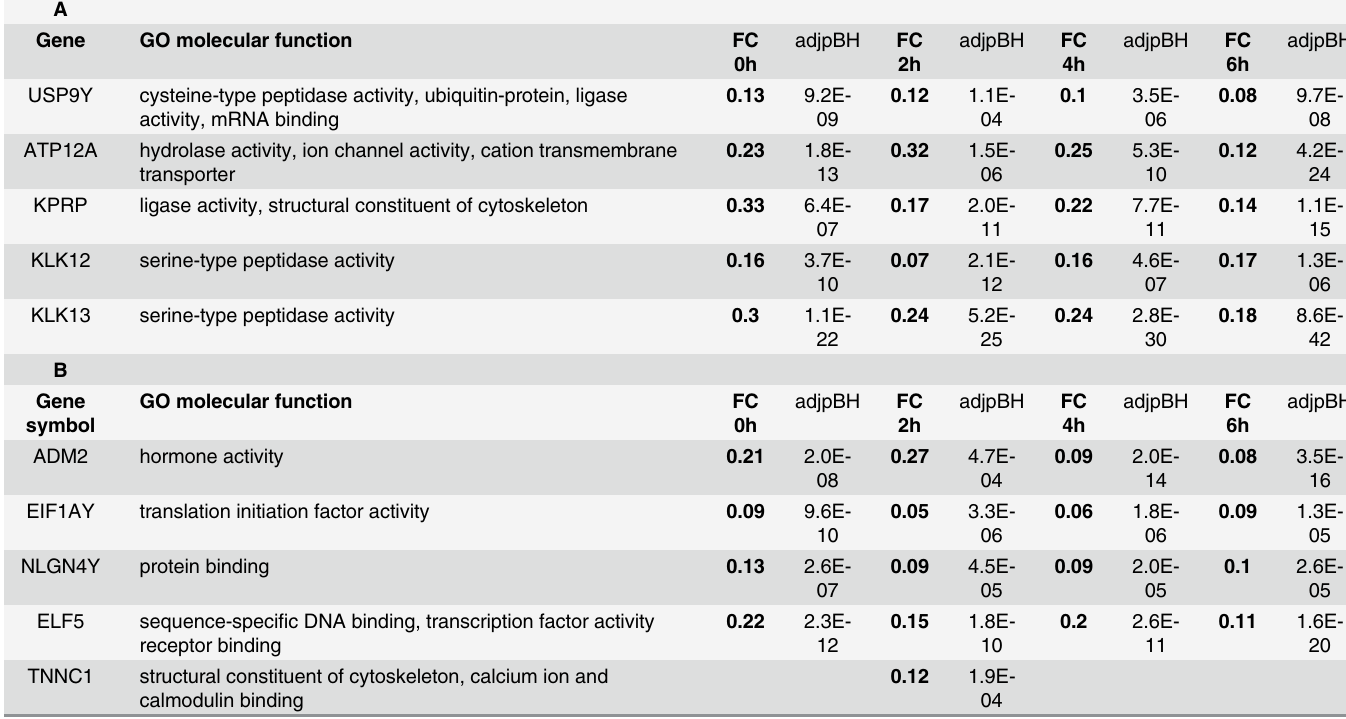
Table 5. Genes in the catalytic-activity (A) and in the protein-binding (B) gene-ontology category: five downregulated genes with the greatest dif- ference in expression level between cystic-fibrosis and CTRL cells after